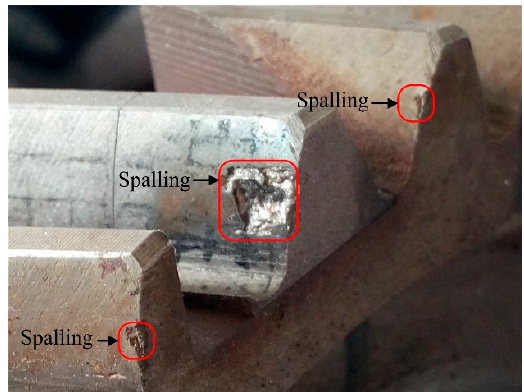
Figure 10. Morphology of the zone near spalling on gear 3 ‐ 2 tooth flank: ( a ) point (V8, H8), ( b ) point (V7, H5), and ( c ) the three ‐ dimensional (3D) morphology of the spalling zone in ( a ) (the purple represents the deeper zone, and the red represents the shallower zone).